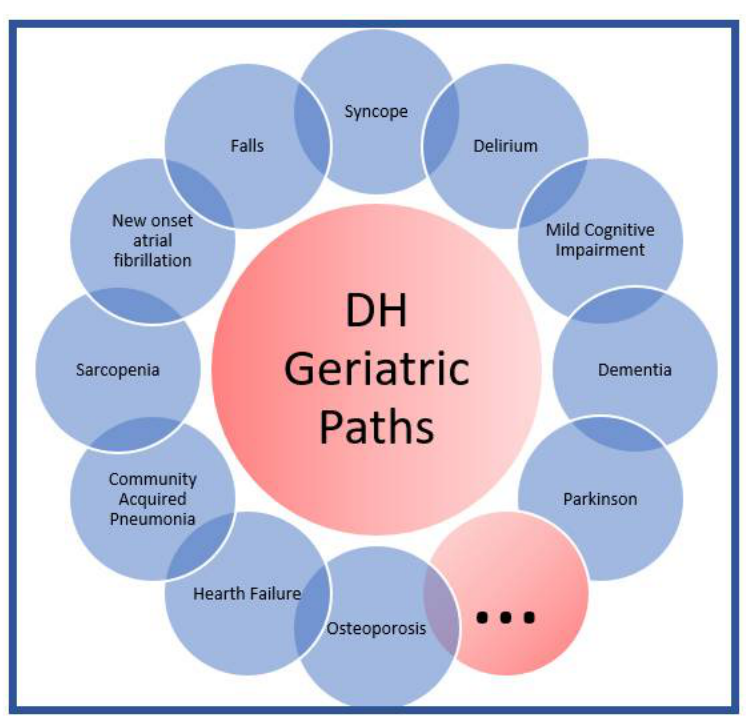
Figure 2. Day Hospital Geriatric Paths.